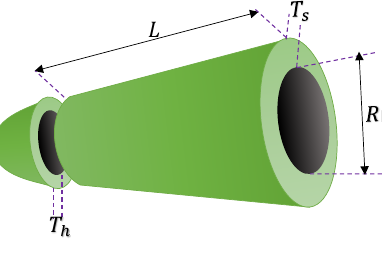
Figure 4. Schematic of the PVD problem.